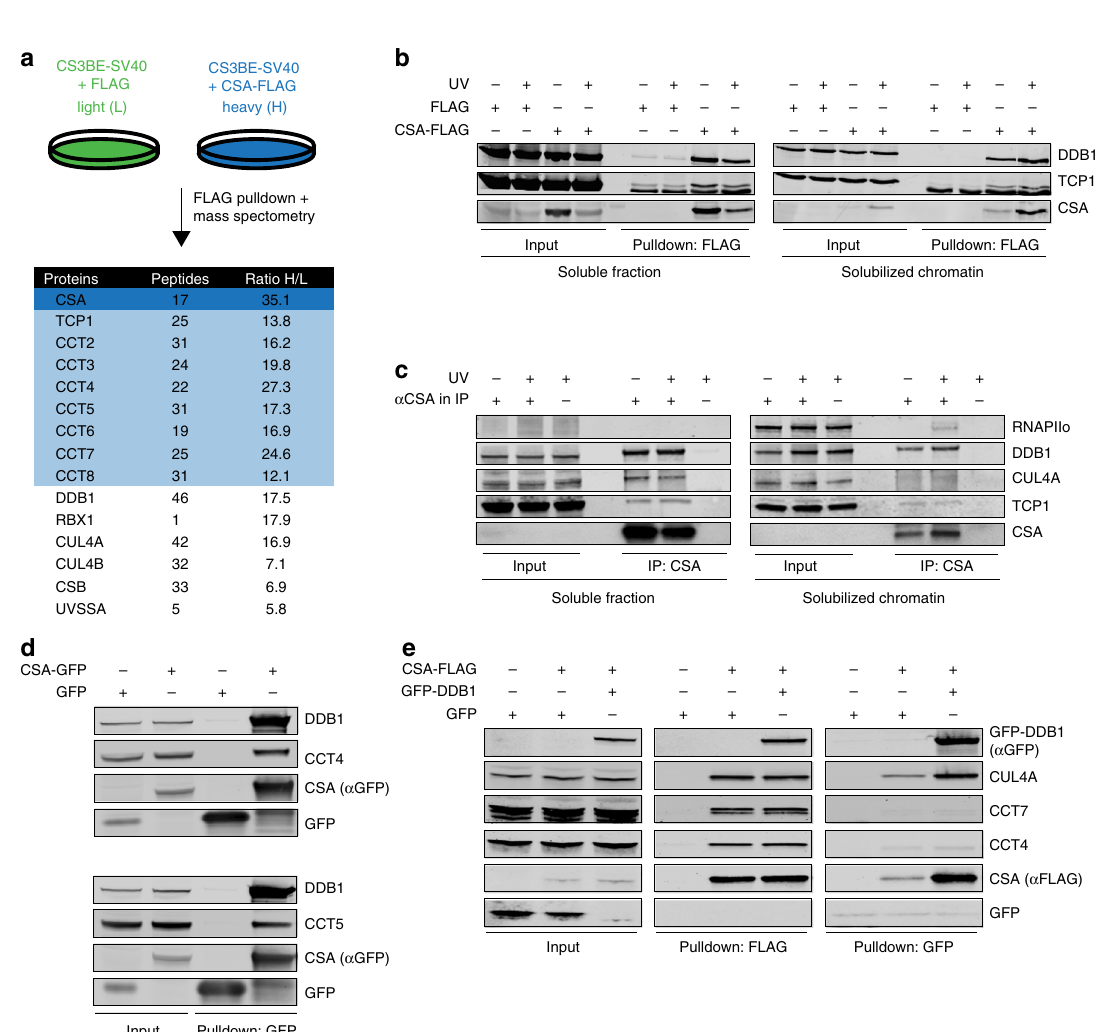
Fig. 1 CSA interacts with chaperonin TRiC. a A SILAC-mass spectrometry approach identi fi ed all TRiC subunits as CSA-interacting proteins. CSA-de fi cient CS3BE-SV40 cells expressing FLAG or CSA-FLAG were cultured in medium containing light or heavy lysine and arginine isotopes, respectively. FLAG- and CSA-FLAG-interacting proteins were pulled down and samples were processed and analyzed by mass spectrometry. The table shows the number of unique peptides found for the top ranked interactors, as well as the ratio of the interactor in the CSA-FLAG pulldown to that in the control FLAG pulldown (ratio H/L). b FLAG pulldowns con fi rm the UV-independent interaction between CSA-FLAG and TCP1. CS3BE-SV40 cells expressing FLAG or CSA-FLAG were mock-treated or UV-C irradiated (20 J/m 2 ). After 1 h of recovery cells were lysed and fractionated into soluble or solubilized chromatin. FLAG pulldowns using both fractions were followed by western blot analysis for the indicated proteins. c CSA co-immunoprecipitation con fi rms the interaction between endogenous CSA and TCP1. As in b , except that VH10-hTert cells were used and that endogenous CSA was immunoprecipitated. d GFP pulldowns con fi rm the interaction between CSA and TRiC subunits CCT4 and CCT5. GFP or CSA-GFP was pulled down from CS3BE-SV40 cells. e Tandem FLAG and GFP pulldowns show preferential binding of TRiC to DDB1/CUL4A/RBX1-free CSA. CSA-FLAG, GFP, and GFP-DDB1 were expressed in U2OS cells as indicated. Enrichment of CSA-interacting proteins by means of FLAG pulldowns con fi rmed interactions between CSA and DDB1 and CUL4A, as well as the TRiC subunits CCT4 and CCT7. Subsequently, eluted protein complexes were subjected to pulldown of GFP-DDB1, revealing an interaction with CUL4A, but not CCT4 and CCT7. Full-size scans of western blots are provided in Supplementary Fig.